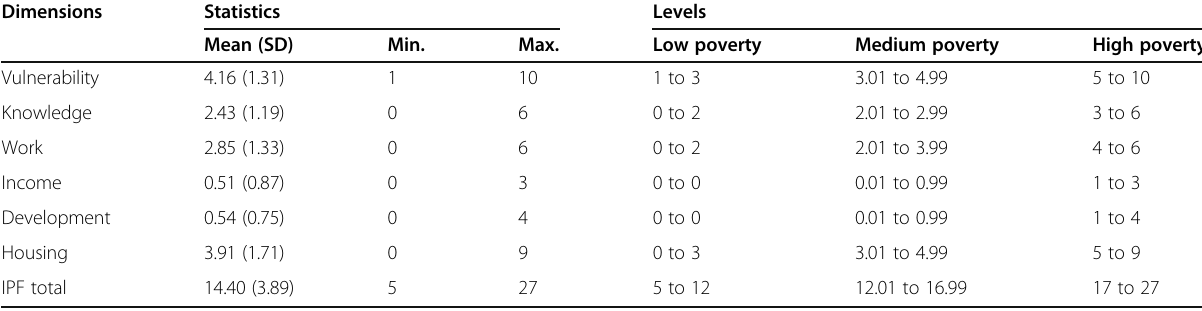
Table 1 Statistics and categories concerning the Family Poverty Rate and their dimensions in poor families in the city of Belém (PA)